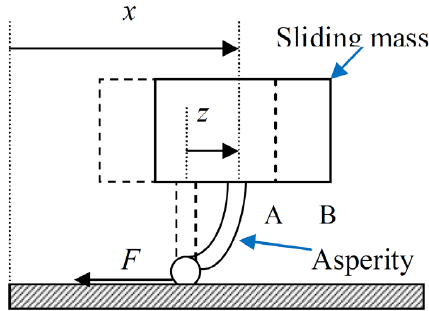
Figure 4. Illustration of deformation of asperity on the frictional